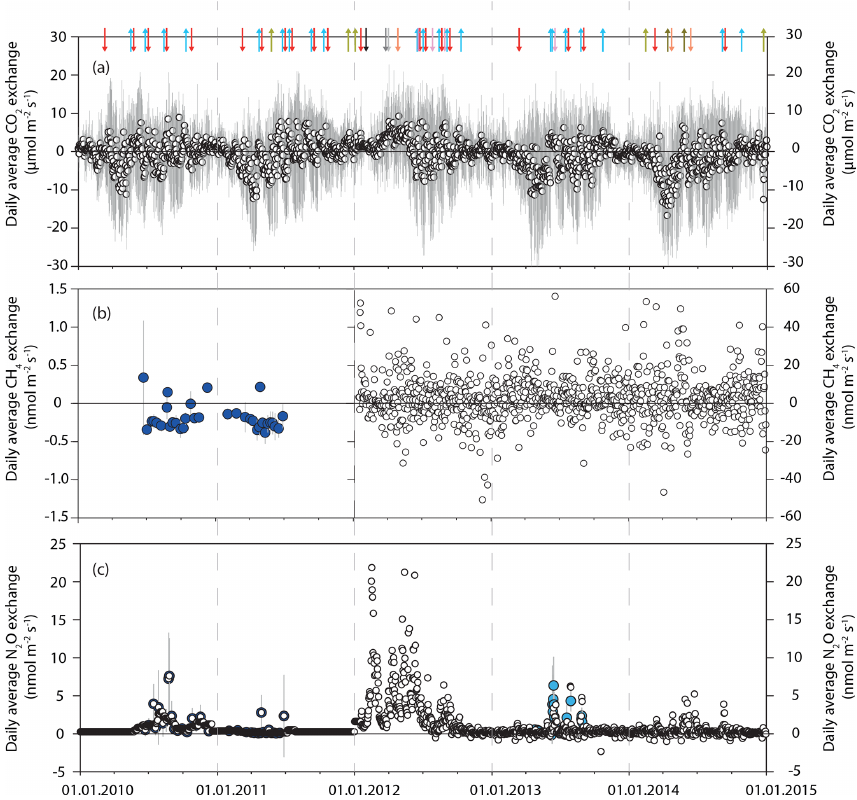
Figure 4. Temporal dynamics of gap-filled (except methane in 2010–2011) daily averaged greenhouse gas (GHG) fluxes (white circles): (a) CO 2 exchange in µmolm − 2 s − 1 , (b) CH 4 exchange in nmolm − 2 s − 1 and (c) N 2 O exchange in nmolm − 2 s − 1 . Colored circles indicate manual chamber measurements. While both GHGs CH 4 and N 2 O were measured in 2010 and 2011 (dark blue circles), only N 2 O was measured in 2013 (light blue circles). The dashed grey lines indicate the beginning of a new year. The same color coding as used in Fig. 3a is used to highlight management activities. Sign convention: positive values denote export or release and negative values import or uptake. Grey lines behind the circles indicate standard